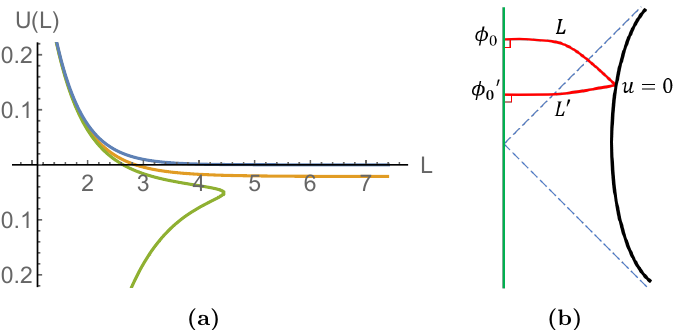
Figure 19. (a) U( L ) for different ζ , where blue is for ζ = 0 , yellow is for 0 < ζ < ζ cr and green is for ζ > ζ cr . (b) ζ > ζ cr . Black curve is AdS boundary, green line is µ = 0 EOW brane, dashed lines are horizon and red curves are two geodesics. In this case, there is an ambiguity of choice of geodesics emanating from the same boundary point at u = 0 . In both plots, 2 φ b = 1